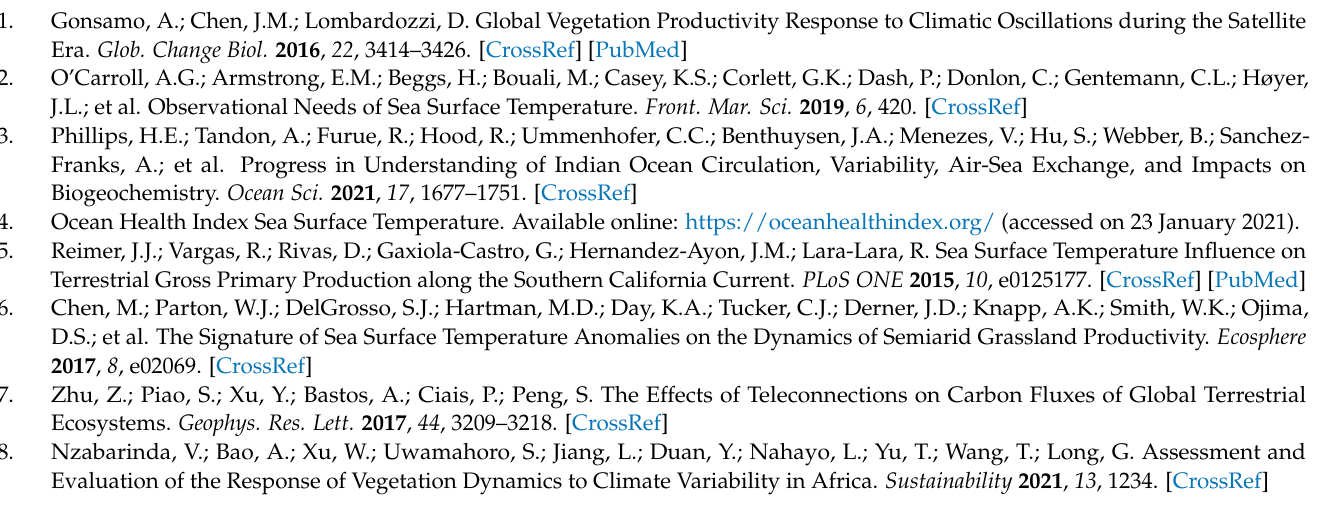
Ocean (a,d), Northern Indian Ocean (b,e), and Central Indian Ocean (c,f) demonstrated positive (upper) and negative (lower) variations. Figure S7: Density contour plot of summer monsoon wind at 850 hPa during June when, SST anomalies of the Western Indian Ocean (a,d), Northern Indian Ocean (b,e), and Central Indian Ocean (c,f) demonstrated positive (upper) and negative (lower) variations. Colouration indicates the density estimate of wind speed anomalies, which are statistically significant and the arrows indicate the wind direction. Figure S8: Shows the correlation of SIF anomalies with NINO3 SST anomalies during June at (i) lag 0, (ii) lag 1, (iii) lag 2, (iv) lag 3, and (v) lag (iv), and